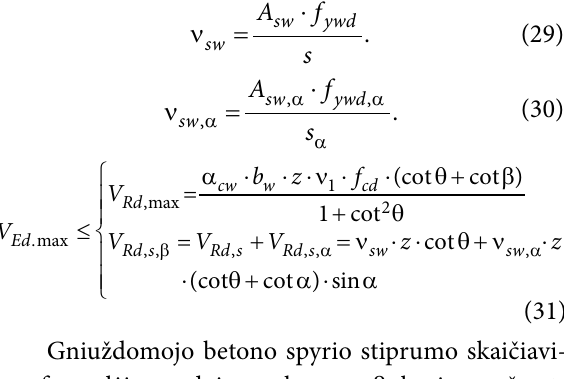
Skersin posvyrioės armatūros kampas ( ), ° (cid:31)